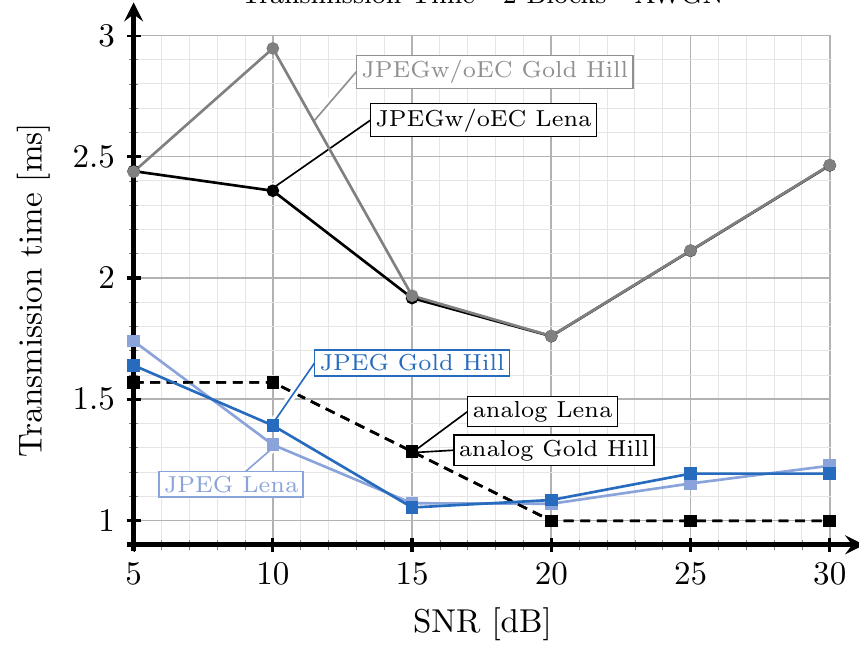
Figure 8. Transmission time vs. the signal to noise ratio (SNR) for two blocks and additive white Gaussian noise (AWGN)